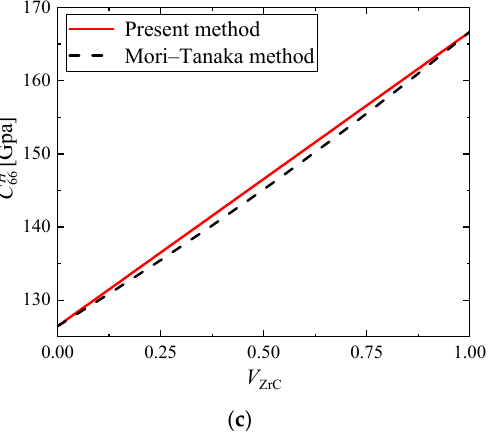
Figure 4. Comparison of two methods for effective elastic tensor’s components ( a ) C 11 H ; ( b ) C 12 H ; ( c ) C 66 H .